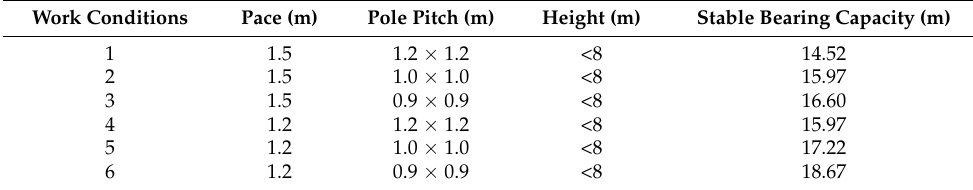
Table 7. Limits of the standard bearing capacity of vertical pole